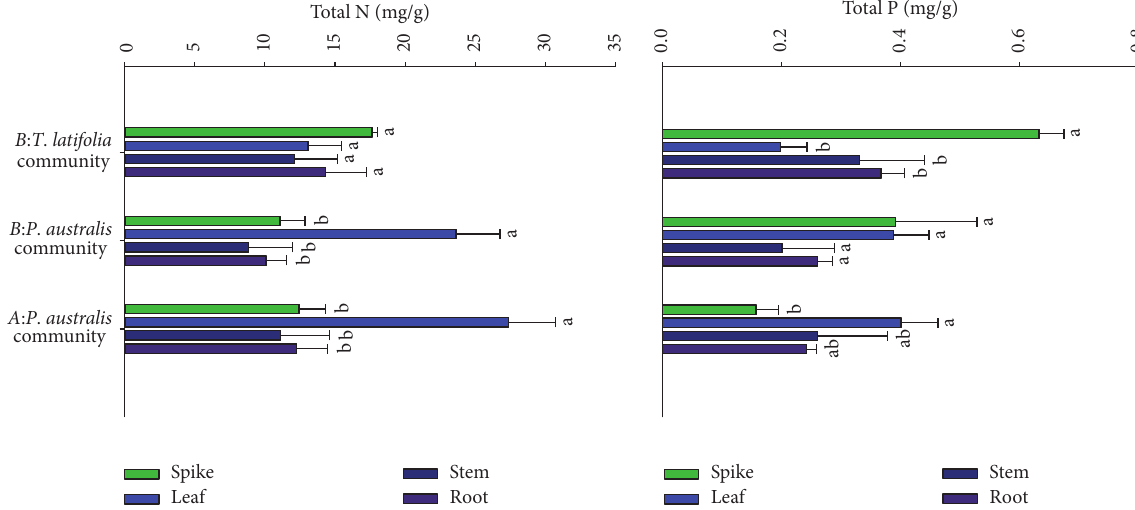
Figure 2: Concentration of TN and TP in the organs of P . australis and T . latifolia in experimental sites. Different lowercase letters indicate significant difference among TN and TP contents of organs ( 𝑃 < 0.05 ). Values are mean + 1 sem.